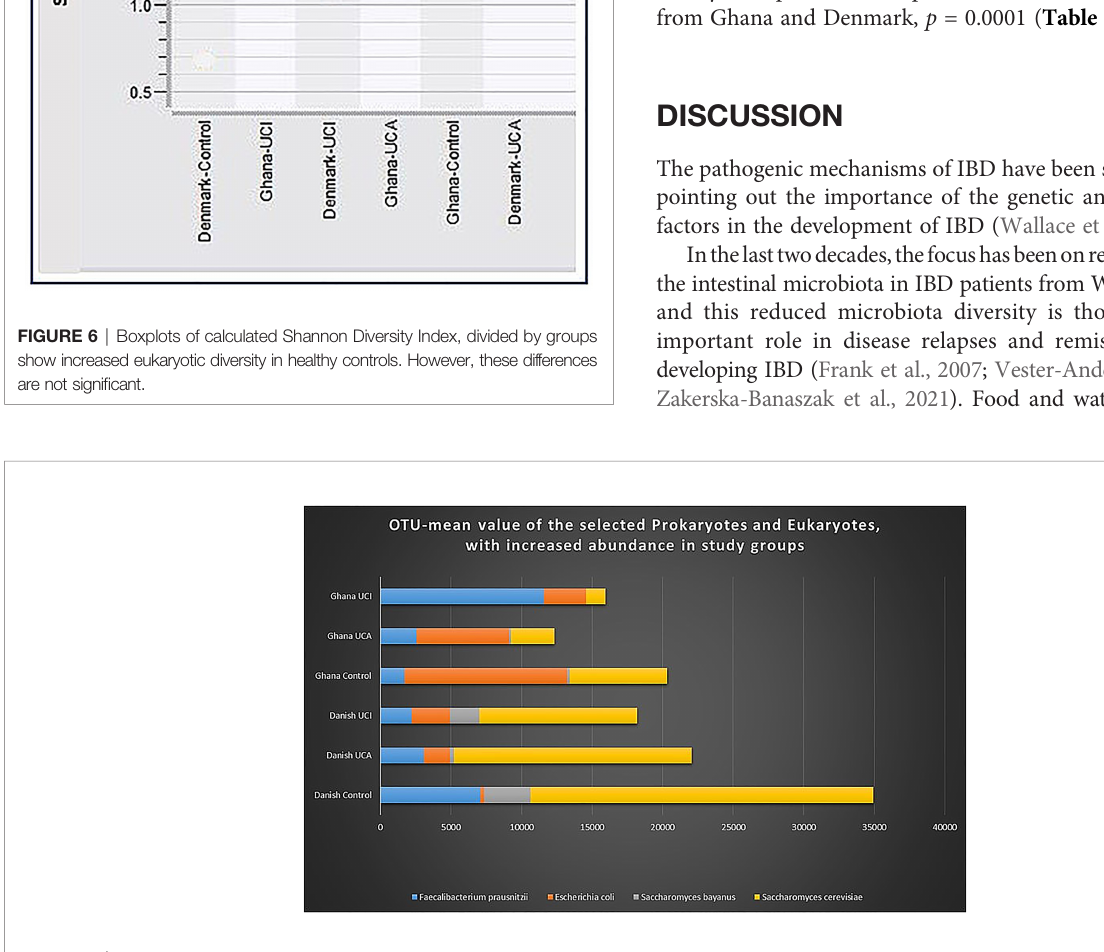
FIGURE 7 | Graph shows OTU-mean value for selected prokaryotes and eukaryotes with increased abundance. As it is shown in the graph, E. coli , Saccharomyes , and Faecalibacterium are selected for highest peaks among other species found in the stool of the study